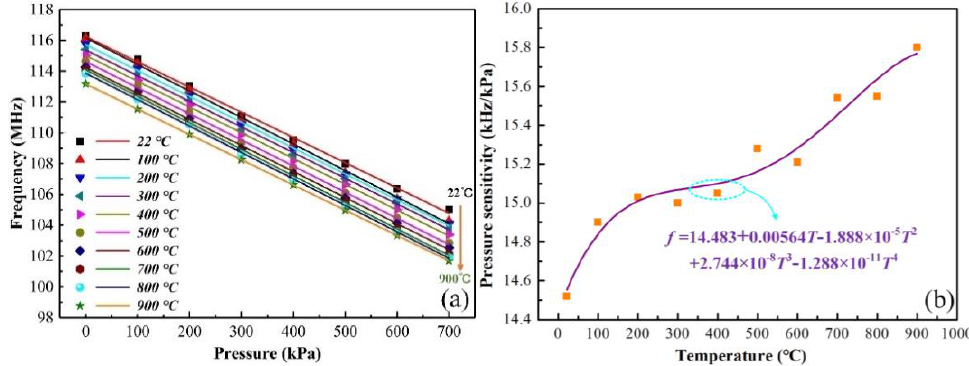
Figure 8. ( a ) The pressure versus resonant frequency curve at temperatures of 22 – 900 °C. ( b ) The pressure sensitivity of the sensor at different temperatures.